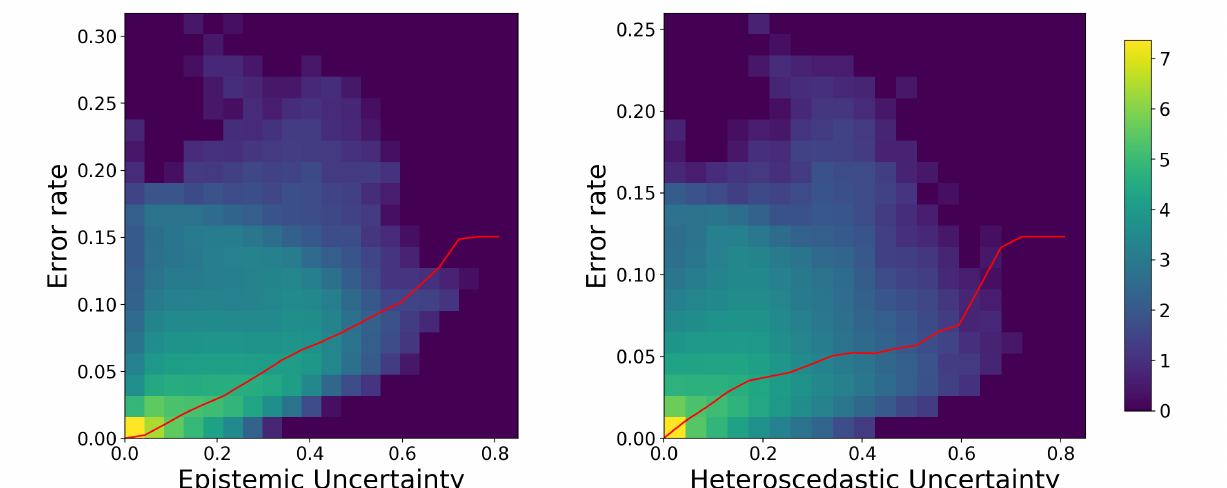
Figure 4. Joint histogram of prediction uncertainty and error rate for MultiRes unc network: Epistemic ( left ), Heteroscedastic ( right ). Low correlation between uncertainty and error rate is shown in purple and high correlation is shown in yellow. The average error rate at different levels of uncertainty is depicted by the red line. The error rate tends to increase with a higher uncertainty, which shows that the network correlates uncertainty to regions of high